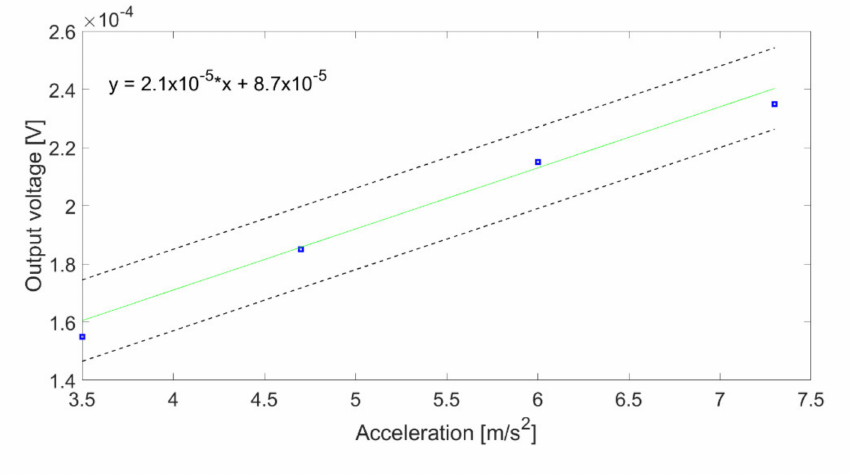
Figure 10. Characterization diagram of the conceived sensor. The solid line indicates the characteristic line. The dotted lines indicate the corresponding